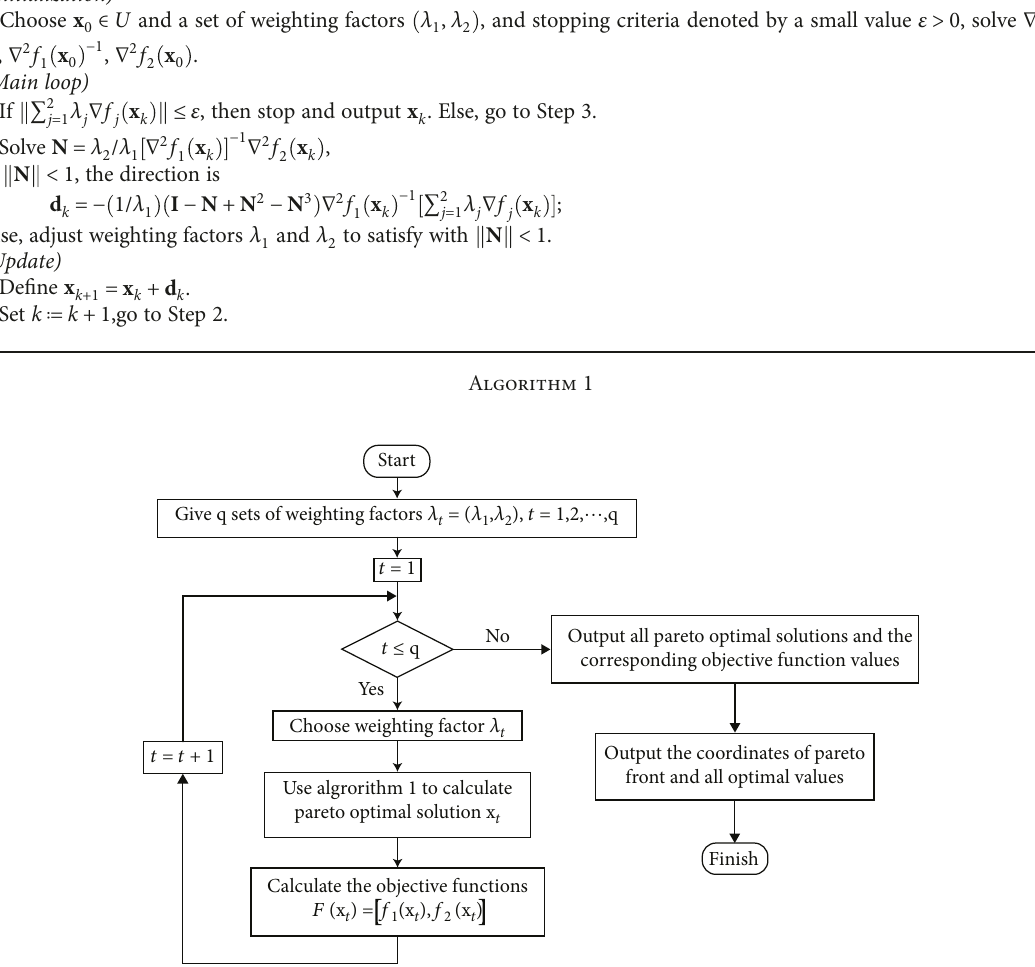
Figure 1: The process of NNSEA for solving unconstrained biobjective